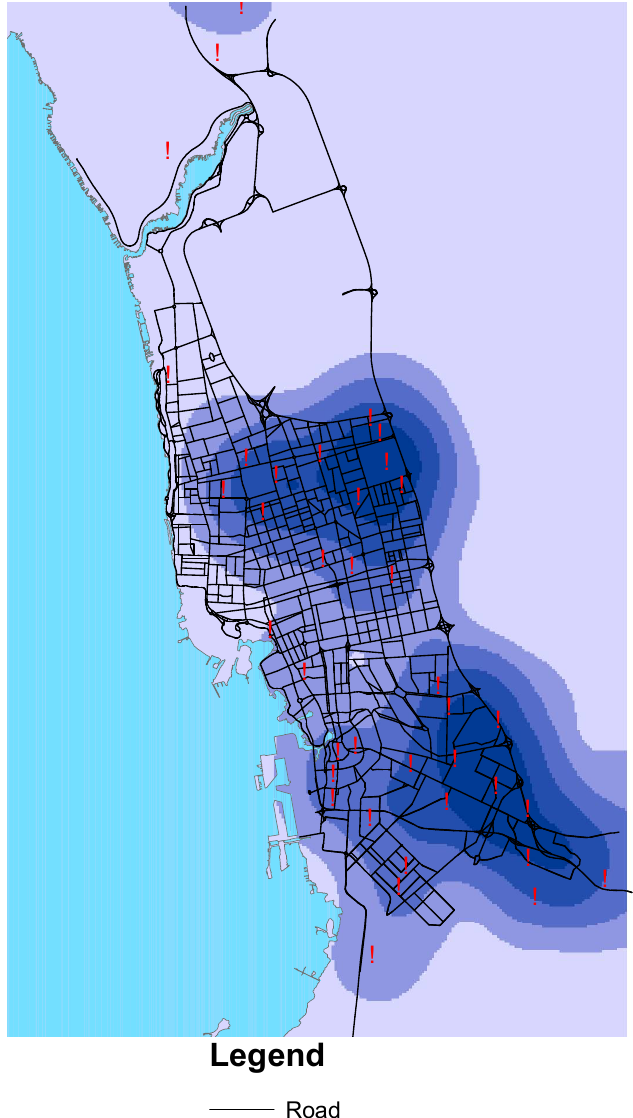
Figure 2. Density of health demand.